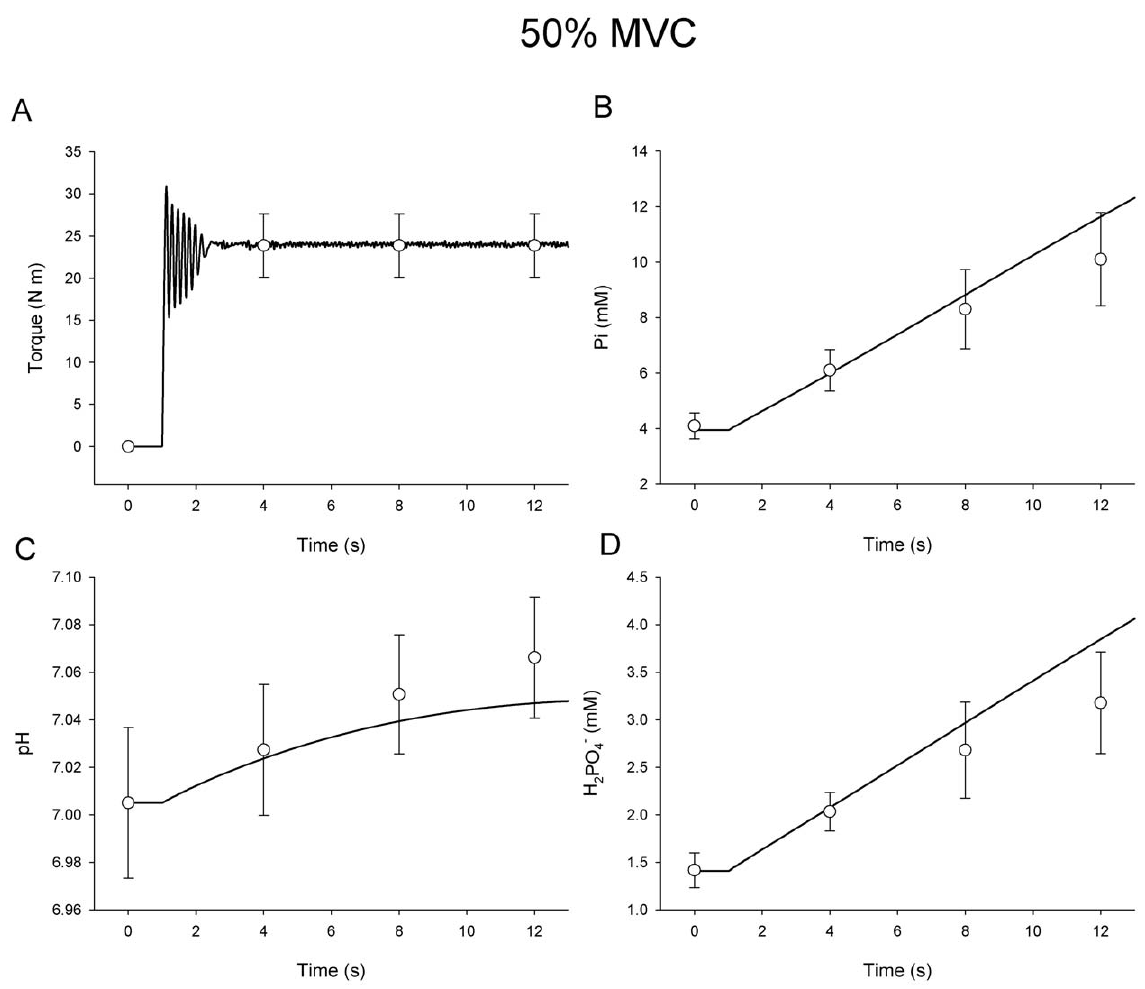
Figure 6. Simulated Submaximal Voluntary Contraction at 50% MVC. Simulated response of Torque ( A ) inorganic phosphate ( B ), pH ( C ), and H 2 PO 4- ( D ) during 12-s contraction (black line). In vivo data (open symbols 6 SD) are shown for comparison.